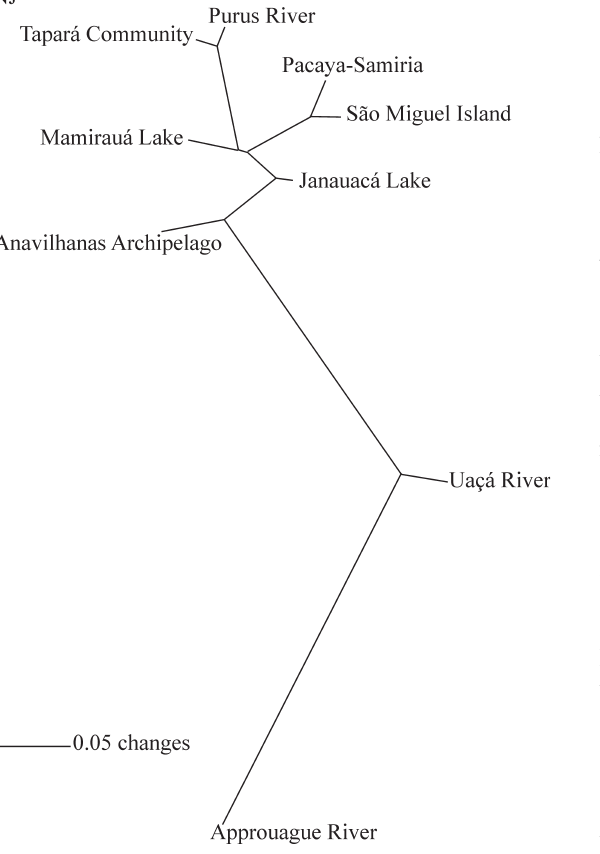
Figure 3 - Unrooted neighbor-joining F ST topology of C. crocodilus sam- pling localities. Branch lengths are proportional to genetic distances. Table 4 - Matrix of pair-wise F ST values (below diagonal) and number of effective migrants ( Nm ) between pairs of populations (above diagonal) separated by geographic distance (above diagonal in parentheses). * Significant values after Bonferroni correction (p < 0.0014).